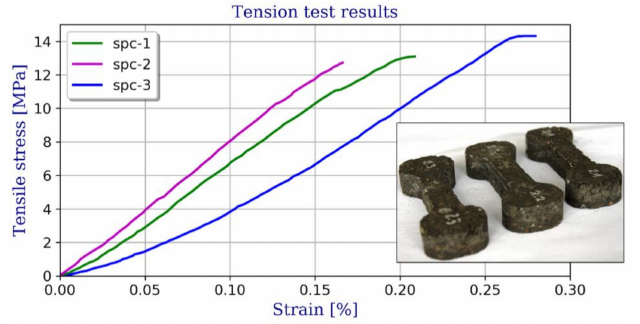
Figure 3. Stress–strain relationships for tension and specimens used for